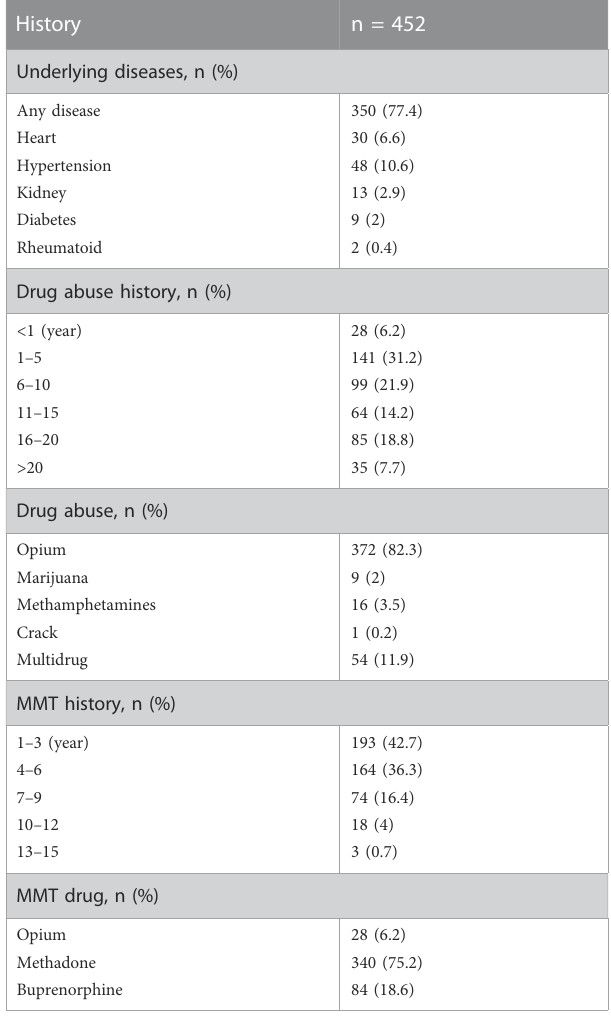
TABLE 1 Demographic information of patients referred to MMT centers. (n = 452).